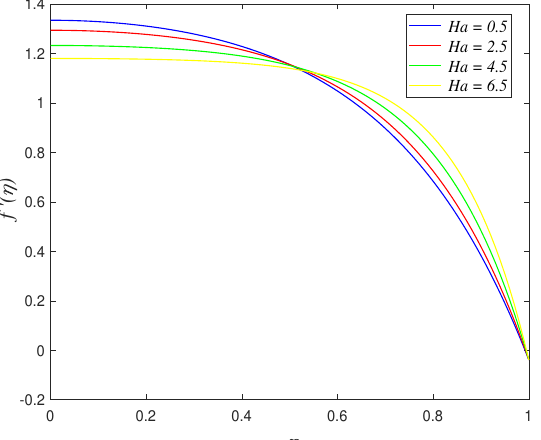
Figure 11. Impact of Ha on axial velocity.